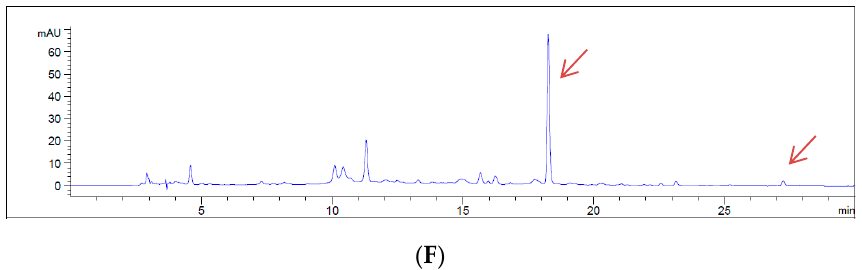
Figure 1. HPLC chromatograms of compounds ( A ) 1 and ( B ) 2 , and the MeOH extracts of ( C ) Geranium eriostemon , ( D ) G. koreanum , ( E ) G. nepalense , and ( F ) G. sibiricum .